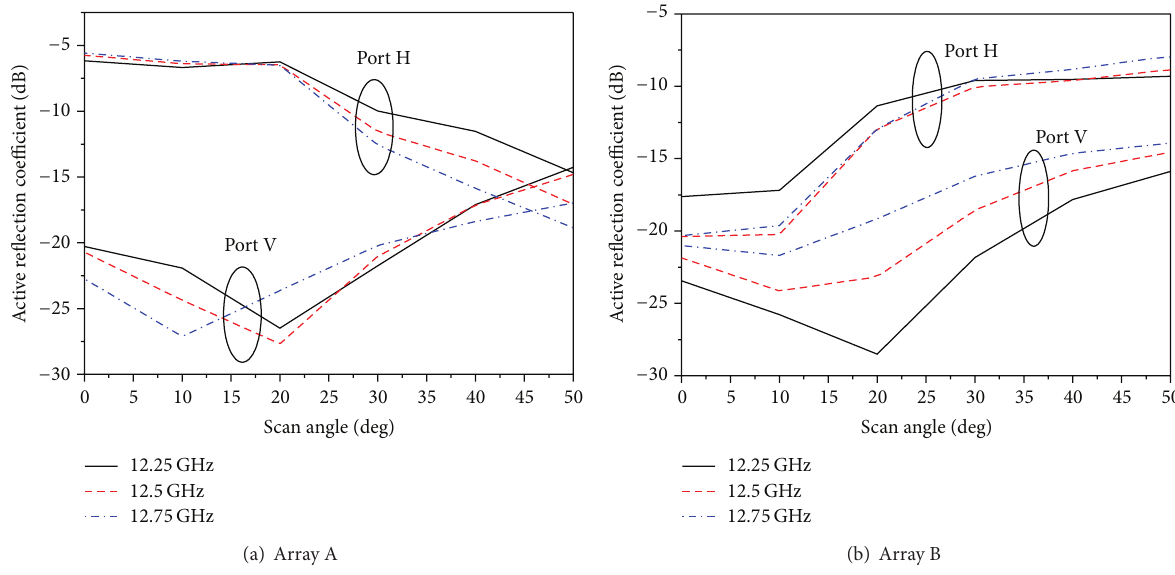
Figure 5: The active reflection coefficient of central element R5-3 (azimuth angle 𝜑 = 0 ∘ , horizontal polarization).